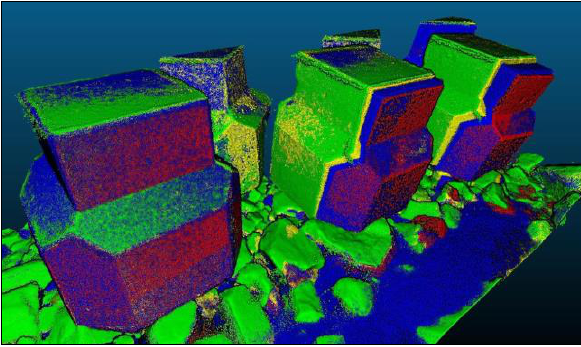
Figure 12 . Close view of the displacements Using the point cloud of differences previously computed between April and November, we measure a displacement (overturning mainly and slight settlement) of 16 cm for the middle block and 23 cm for the block on the far right. Figure 13 shows a cross-section of this block with consistent displacements on both sides. We notice here again that the Figure 10. May / June differences [m] biggest change is observed between April and